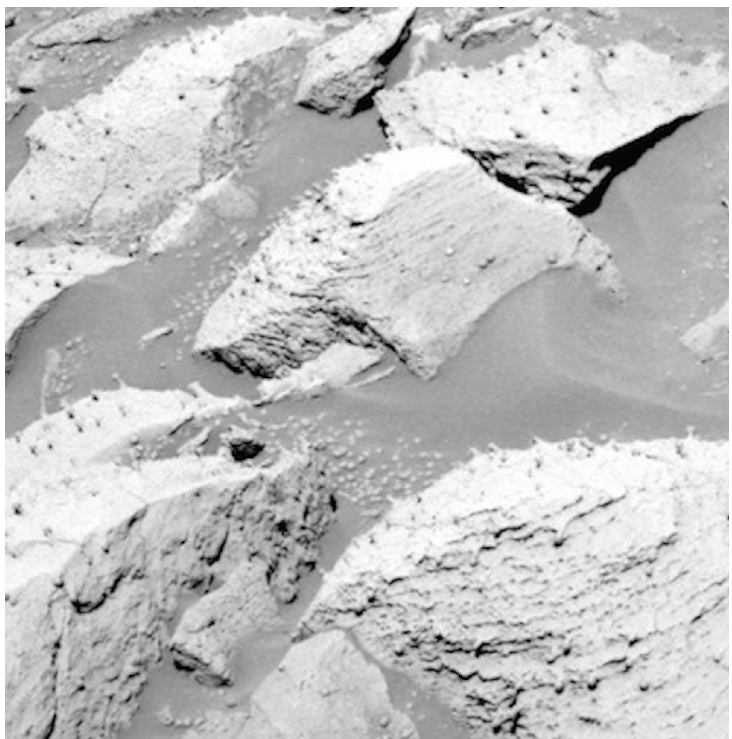
Figure 15. Mars. Sol 85: Examples of vast colonies of lichen-shaped organisms attached to rocks, and oriented skyward similar to photosyn- thesizing lichens. Photographed in Eagle Crater. (Reproduced with permission from Joseph et al.